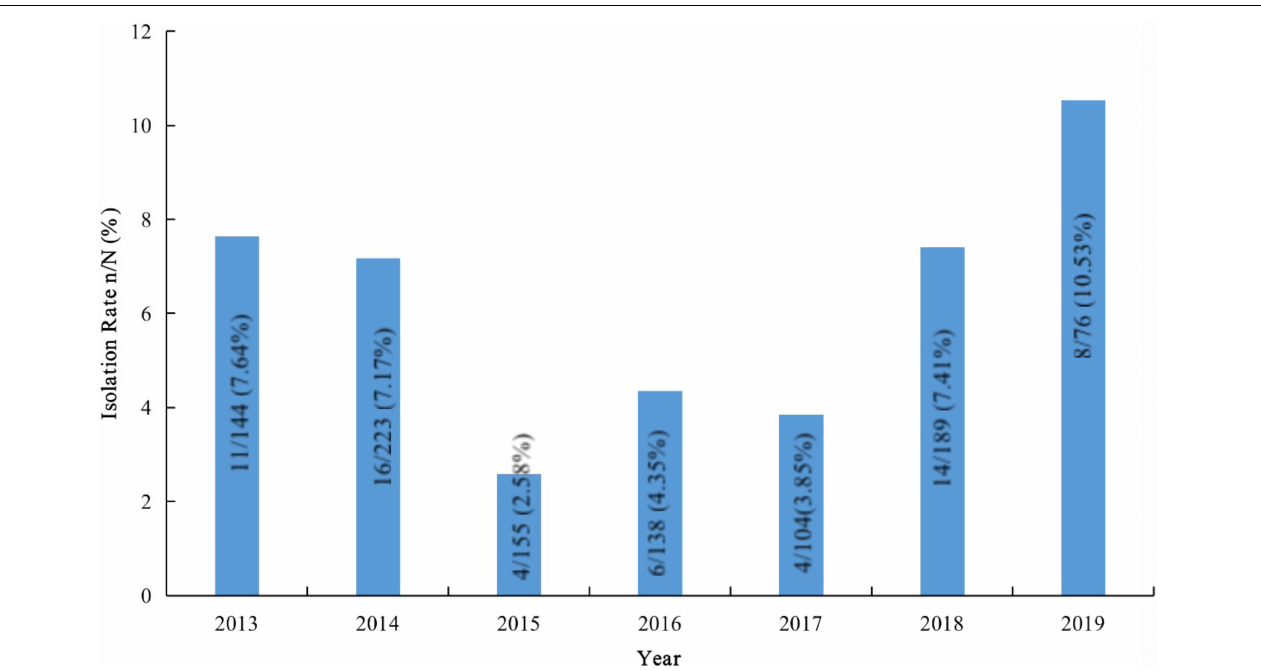
FIGURE 3 | Isolation rates of serogroup 15 Streptococcus pneumoniae strains in samples from Beijing Children’s